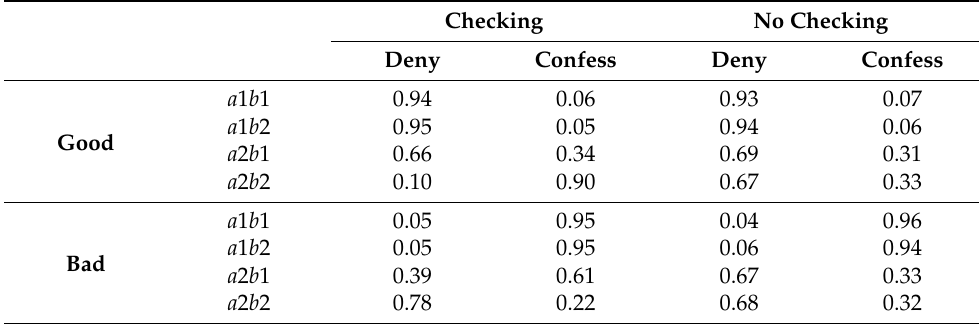
Table 7. Observed probabilities for all forced question combinations in Experiment 2 ( n = 101 for each cell ), split by decision to deny or confess. Checking No Checking Deny